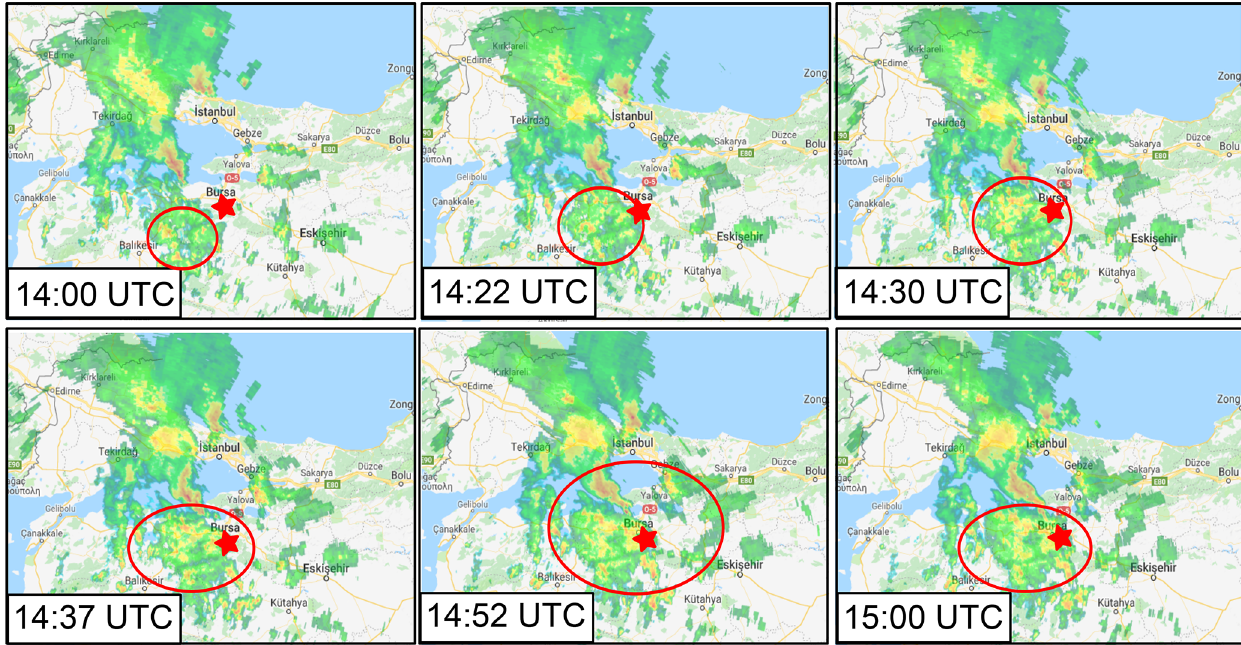
Figure 7. Balikesir radar PPI (plan position indicator) image of the Marmara region on 28 September 2015. The red star marks the Mt. Uludaˇg. The figure was adapted from Google Maps.